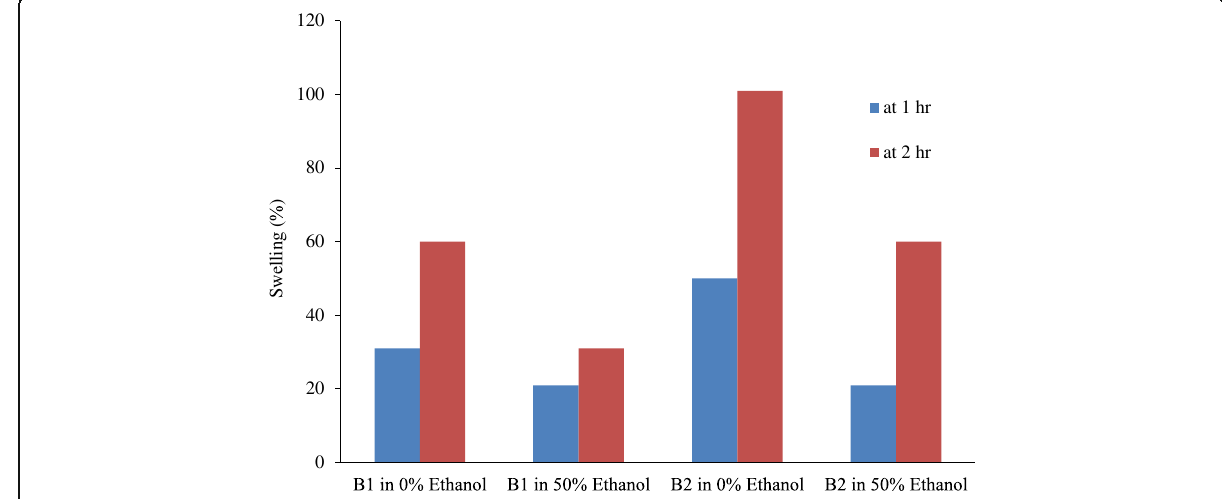
Fig. 11 Effect of alcohol on the swelling property of Carbopol 71G tablets and matrices (data from reference (Emeje et al. 2008))